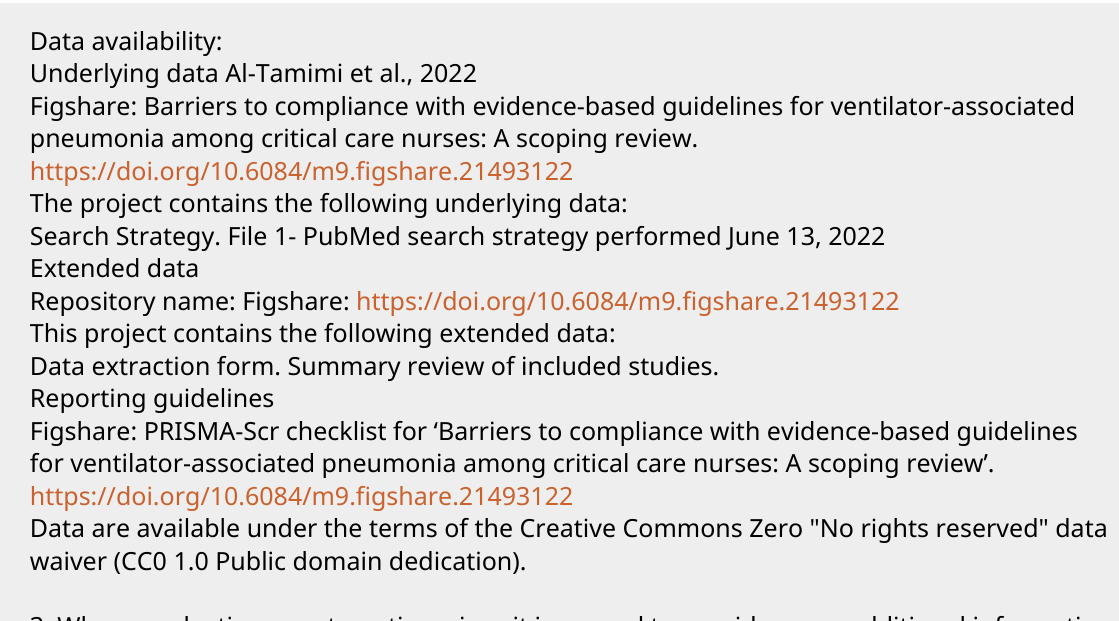
Figshare: Barriers to compliance with evidence-based guidelines for ventilator-associated pneumonia among critical care nurses: A scoping review.